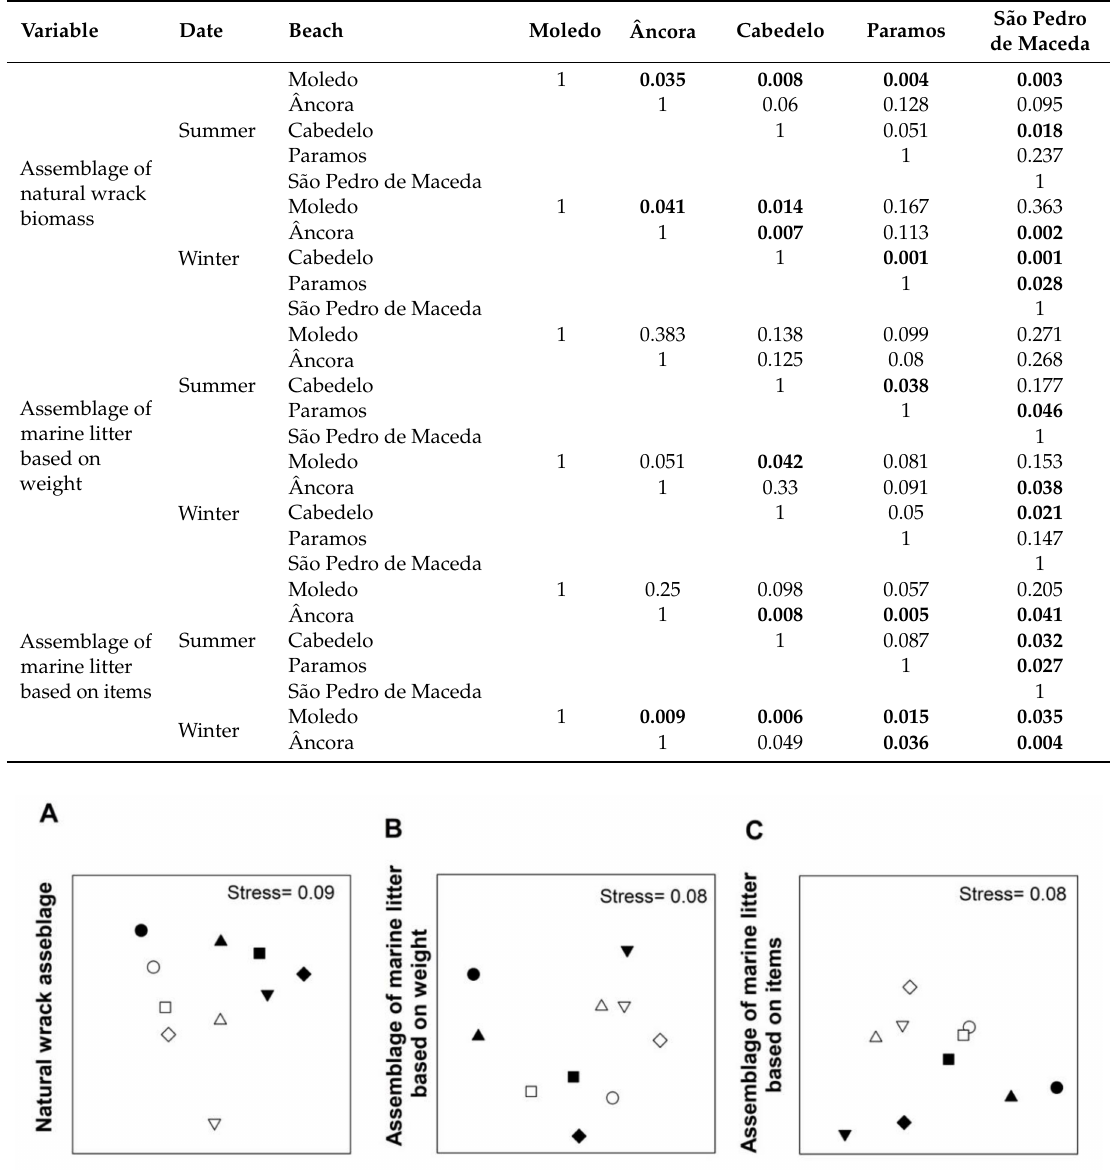
Figure 4. Non-metric multidimensional scaling ordination (nMDS) averaged per beach and by date of the natural wrack assemblage based on species’ biomasses ( A ) and assemblages of marine litter based on weight ( B ) and items ( C ) obtained per transect on each beach of the North of Portugal in the summer of 2019 (white) and in the winter of 2020 (black). Â ncora (upward triangles), Moledo (downward triangles), Cabedelo (circles), Paramos (squares) and S ã o Pedro de Maceda